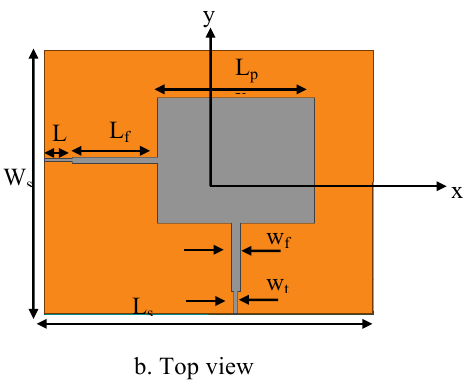
Fig. 5. The configuration of the dual-polarized microstrip patch on-chip antenna with L =2.4 mm, W =2.4 mm, s s h =300 µ m, h =22 µ m, L =1.2 mm, L =0.435 mm, L =0.2 s d p f t mm, w =30 µ m, and w =10 µ f t